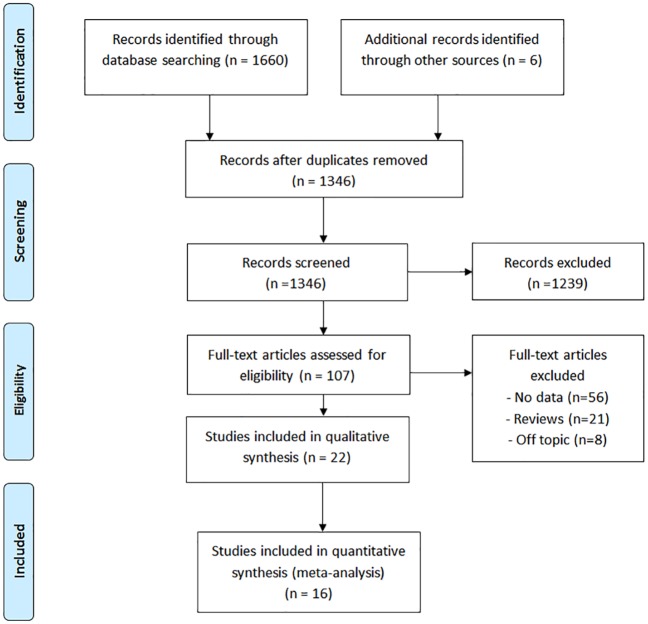
Flow chart of publications identified and excluded for this review.